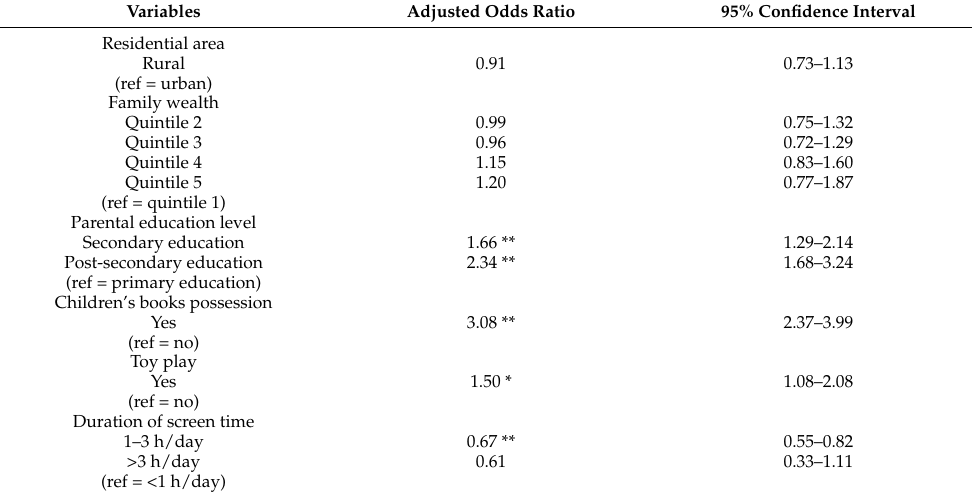
Table 5. Multivariable analysis of having parental interactions of at least four